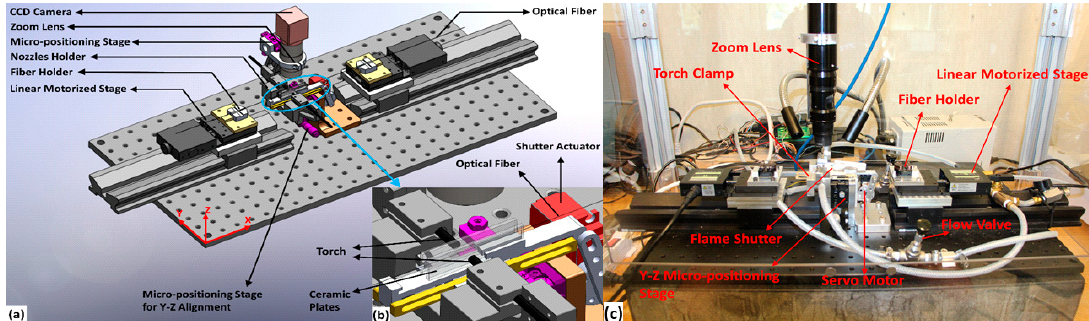
Figure 2. ( a ) Assembly model of the custom flame-based tapering machine and, ( b ) design of the sliding shutter mechanism to control heat delivery to the fiber, and ( c ) assembled custom flame- based tapering machine.